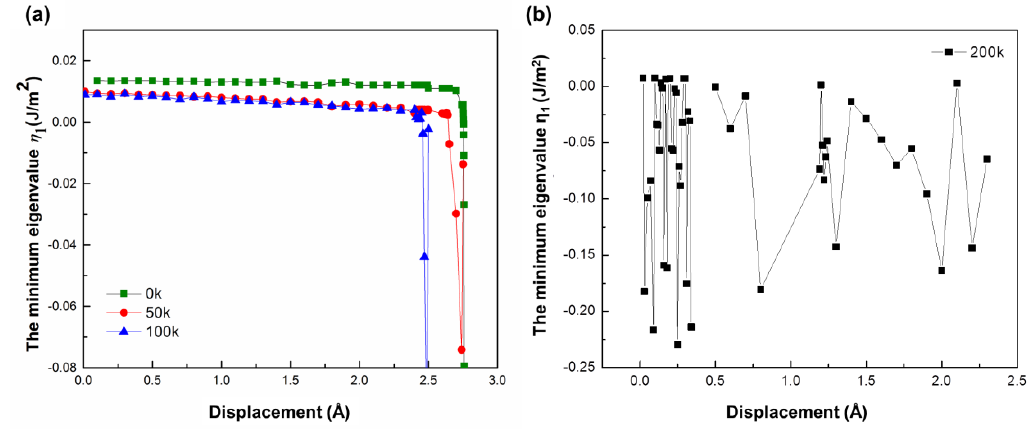
Figure 3. Plots of the calculated minimum eigenvalue ( η 1 ) of matrix A vs. displacement at ( a ) T = 0 K, 50 K, and 100 K. ( b ) T = 200 K. Table 1. Displacement at the first drop point of energy, stress, and minimum eigenvalue at different temperatures.